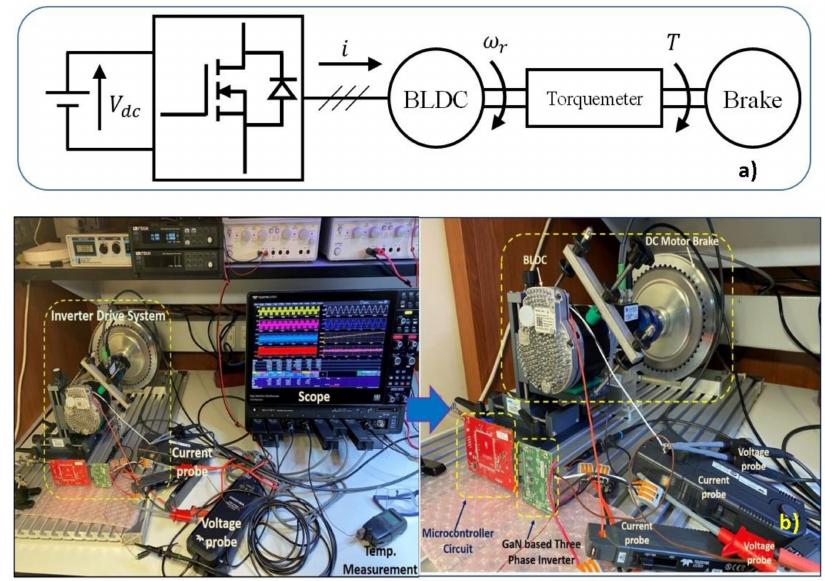
Figure 19. ( a ) Diagram of the experimental setup. The BLDC drive is connected to a brake to regulate torque loading. ( b ) Photo of the experimental